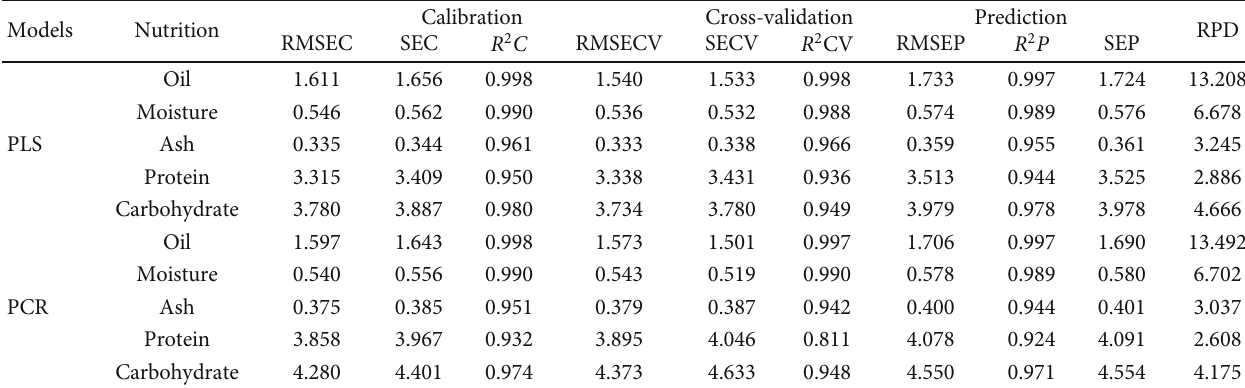
Table 1: Calibration, cross-validation, and prediction in di ff erent models by NIR spectroscopy.